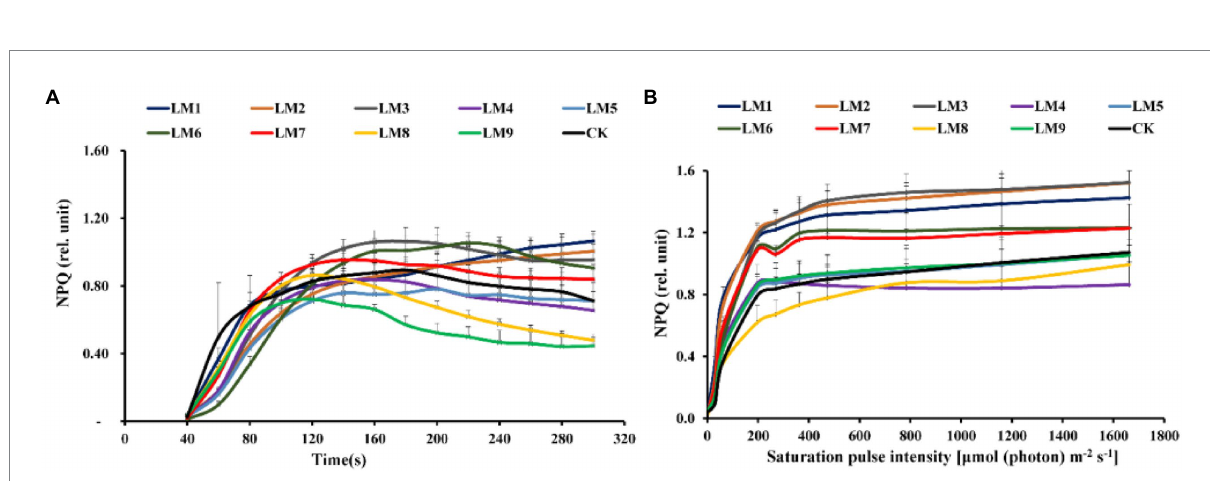
FIGURE 7 Effects of LED light modes on the induction kinetics of chlorophyll a fluorescence in dark-acclimated (A) and light-acclimated (B) of non- photochemical quenching (NPQ) in strawberry leaves. The points represent the means ± SE of 16 (4 × 4) repeats, followed by the identical letters, indicating that the Duncan test found no significant differences ( p ≤